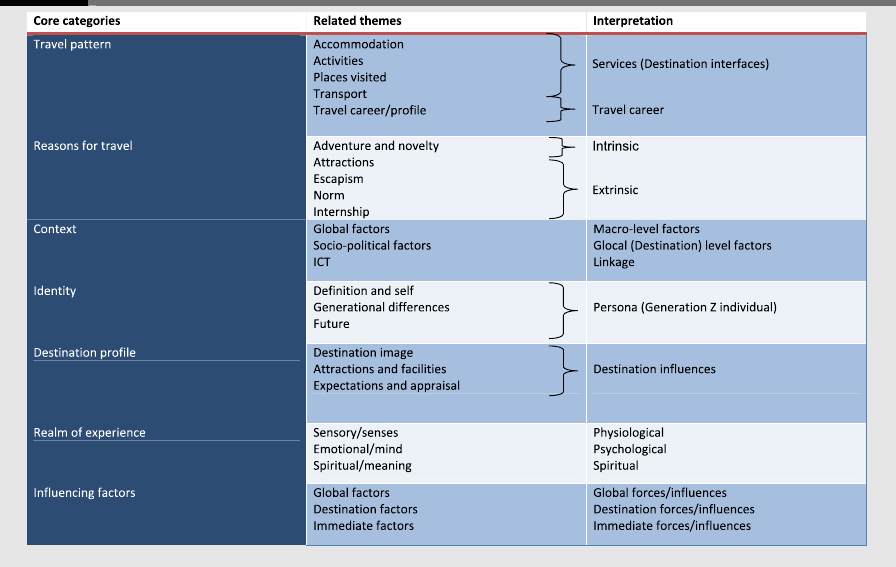
Table II Core categories, related themes and interpretation of Generation Z travel